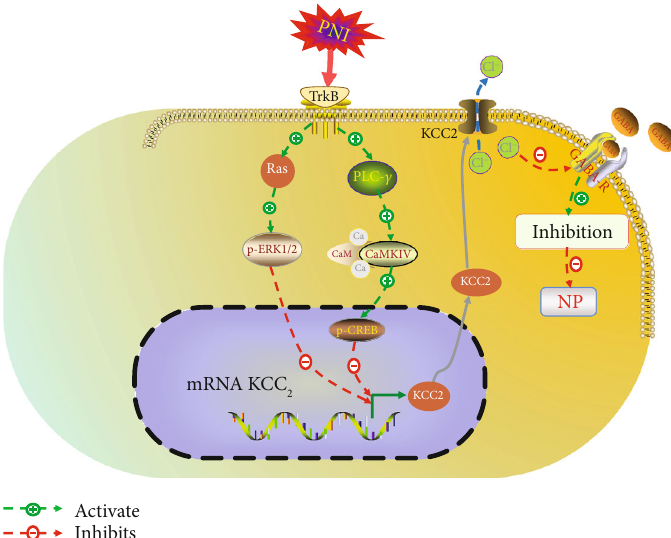
Figure 1: Outline of the current view on the roles of the p-ERK – KCC NP. Under normal conditions, KCC receptor. PNI activates TrkB and then obstructs the translation of KCC